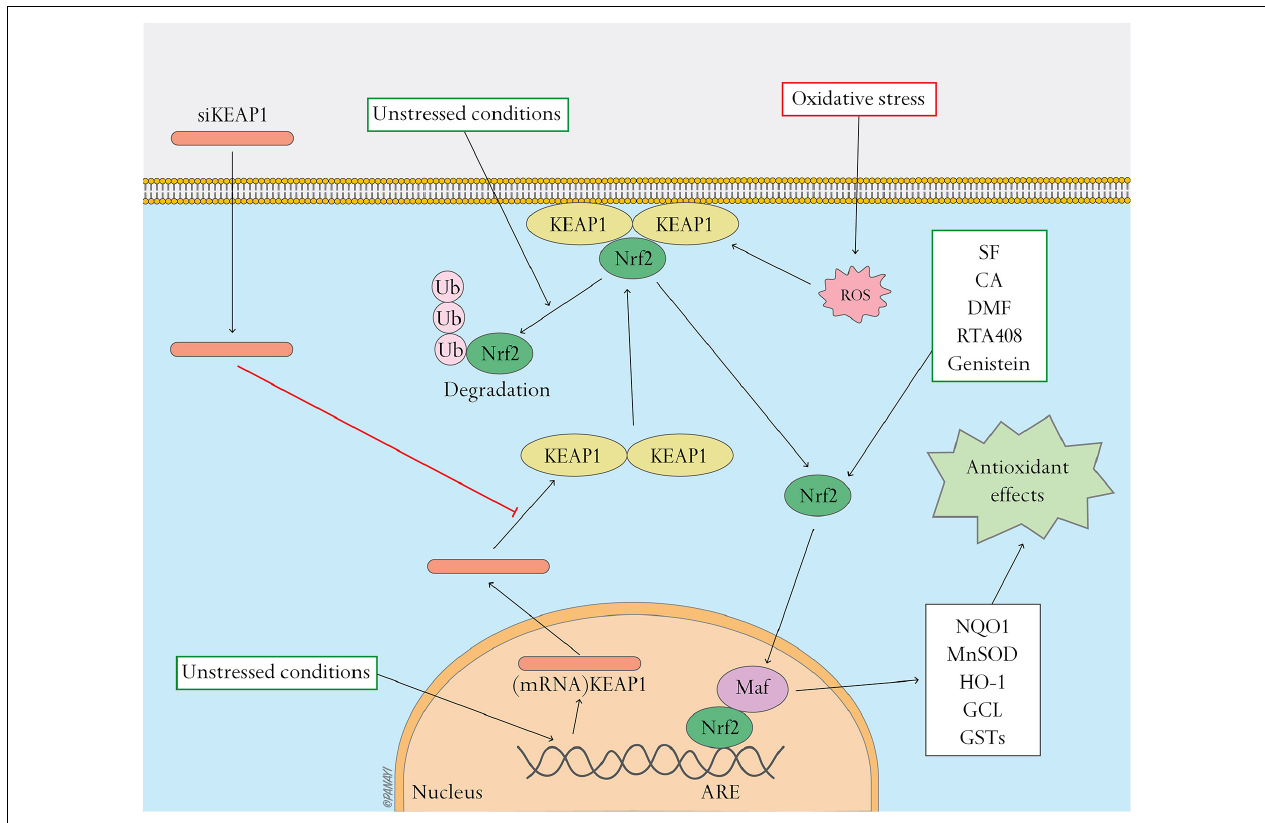
FIGURE 1 | Nrf2 pathway and related antioxidant therapy. Nrf2 pathway and related antioxidant therapy. This figure shows the activation of the Nrf2 pathway and effects of antioxidant therapy targeting this pathway. Under unstressed conditions, Keap1 interacts with Nrf2 and the cell’s actin cytoskeleton to keep Nrf2 inactive in the cytoplasm and promote ubiquitination and degradation of Nrf2. Oxidative stress causes Nrf2 to detach from Keap1 and translocate to the nucleus where it heterodimerizes with Maf. The Nrf2-Maf heterodimer binds to ARE to induce the expression of antioxidant and metabolic genes including NQO1, MnSOD, HO-1, GCL, and GSTs. Oxidative stress can be regulated by activating the Nrf2 pathway. siKeap1 downregulates the levels of Keap1 by incorporating into an RNA-induced silencing complex (RISC) and inducing degradation of the complementary mRNA of Keap1. Nrf2 activators, such as SF, CA, DMF, RTA408 and genistein, stimulate the Nrf2 pathway and ameliorate oxidative